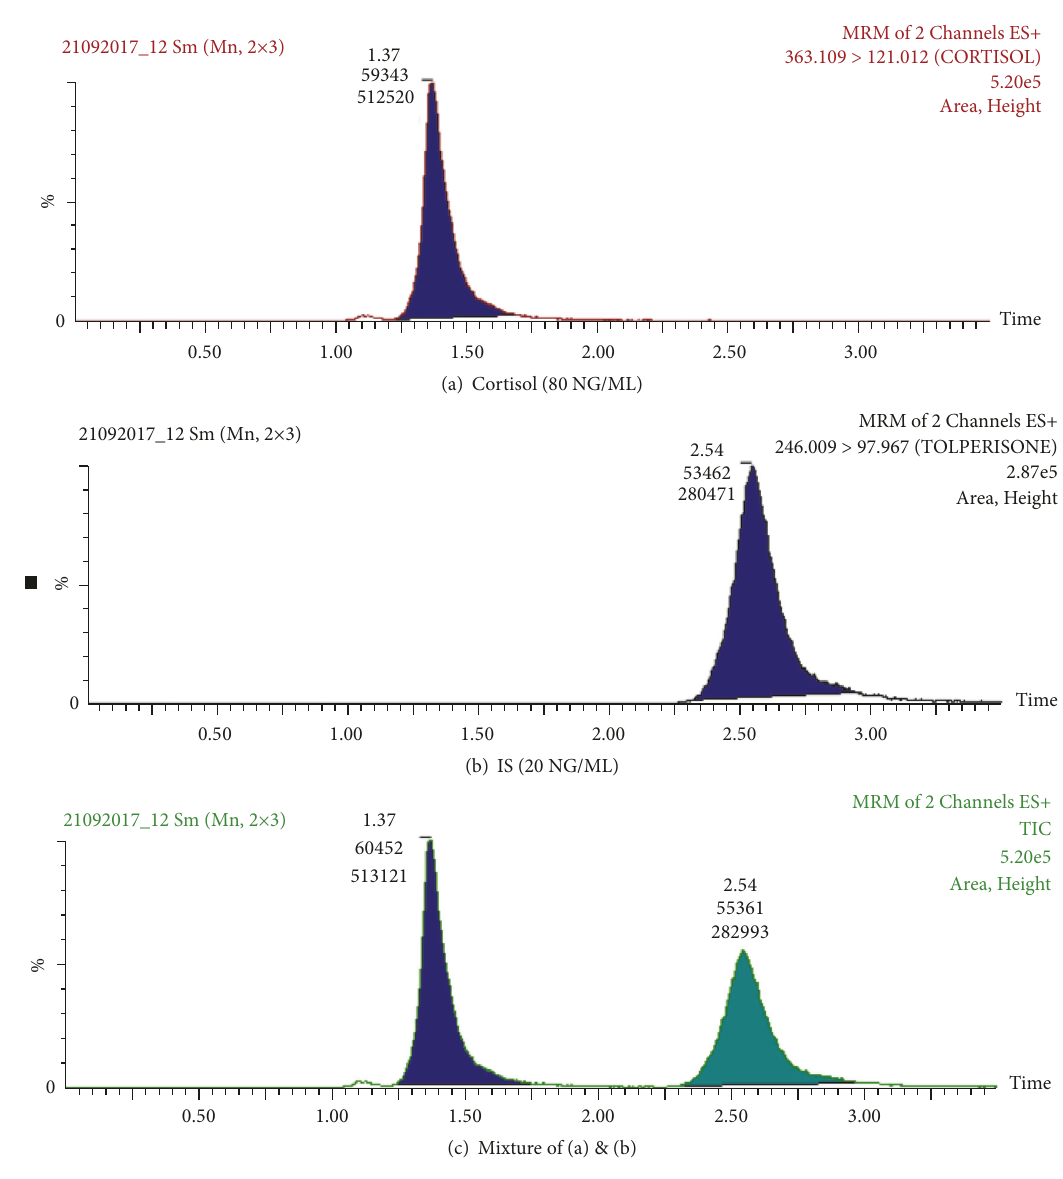
Figure 2: Total ion current and multiple reaction monitoring chromatograms of cortisol and the internal standard (IS) tolperisone in human saliva. Table 1: Extraction recovery of cortisol and internal standard (IS) from